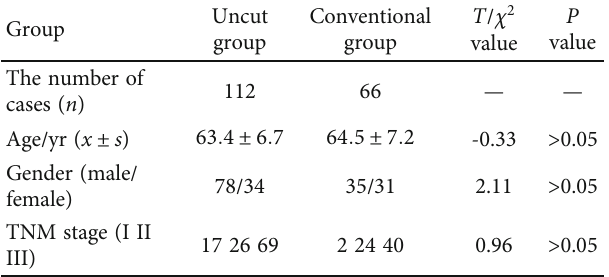
Table 1: The clinical features of two groups of patients.